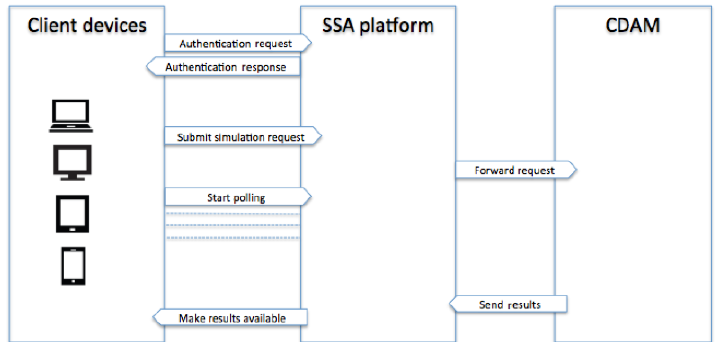
Figure 4. Data flow among OCEAN-SAR components.